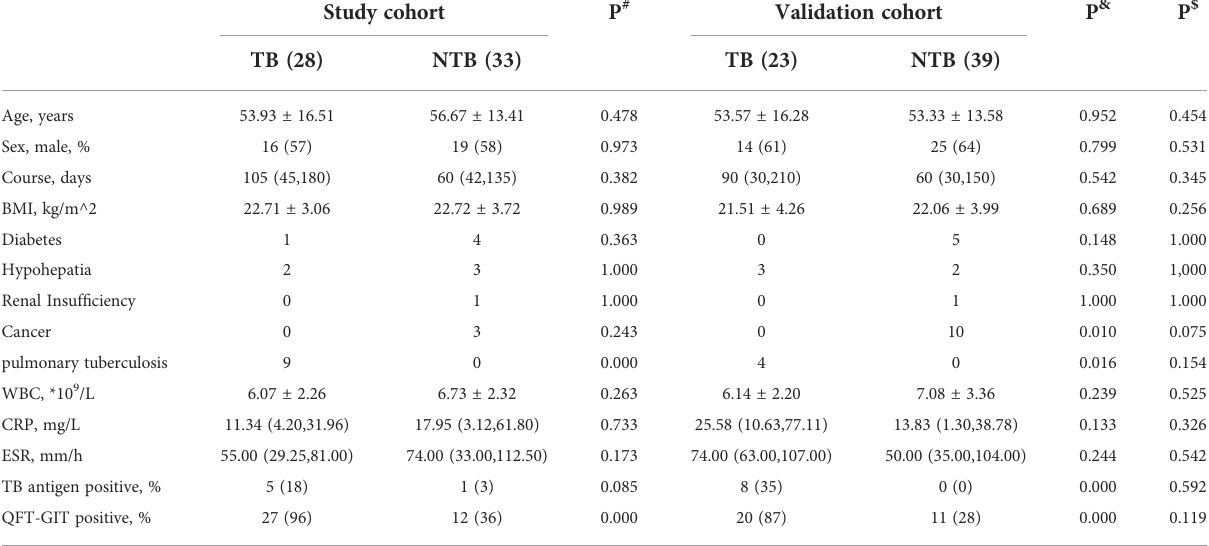
TABLE 1 The clinical characteristics of recruited patients in two independent